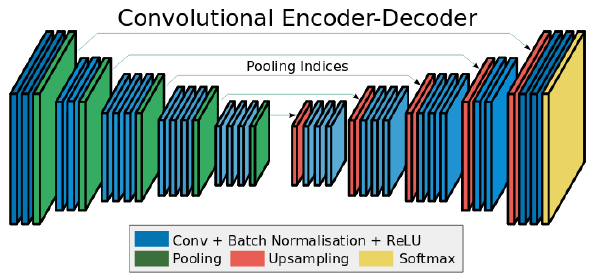
Figure 4: Encoder-decoder architecture of the implemented CNN. Image modified from (Badrinarayanan et al.,